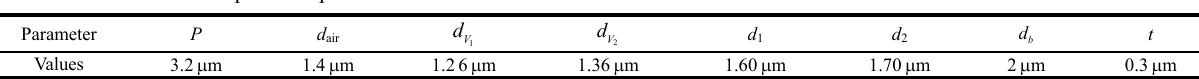
Table 4 Values of the optimized